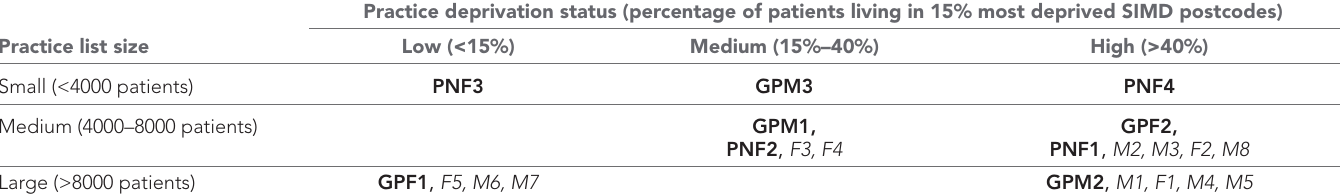
Table 1 Sampling frame of patients (in italics ) and practitioners (in bold)